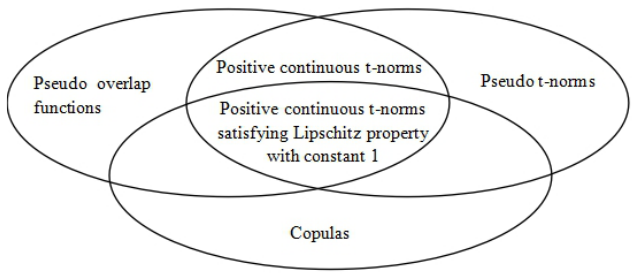
Figure 2. Intersection of the main classes of aggregation functions considered in this